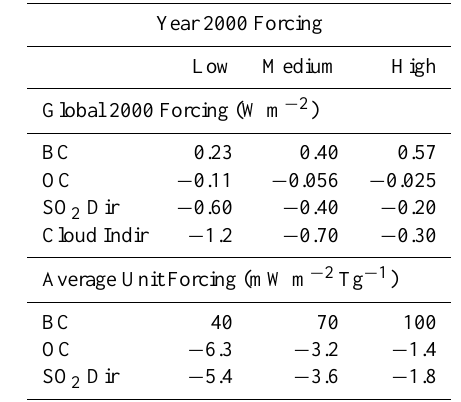
Table 1. Assumed range for radiative forcing. Year 2000 anthro- pogenic emissions (total emissions – assumed preindustrial base- line) are BC: 5.7TgC; OC: 17.4TgC; SO 2 : 111TgSO 2